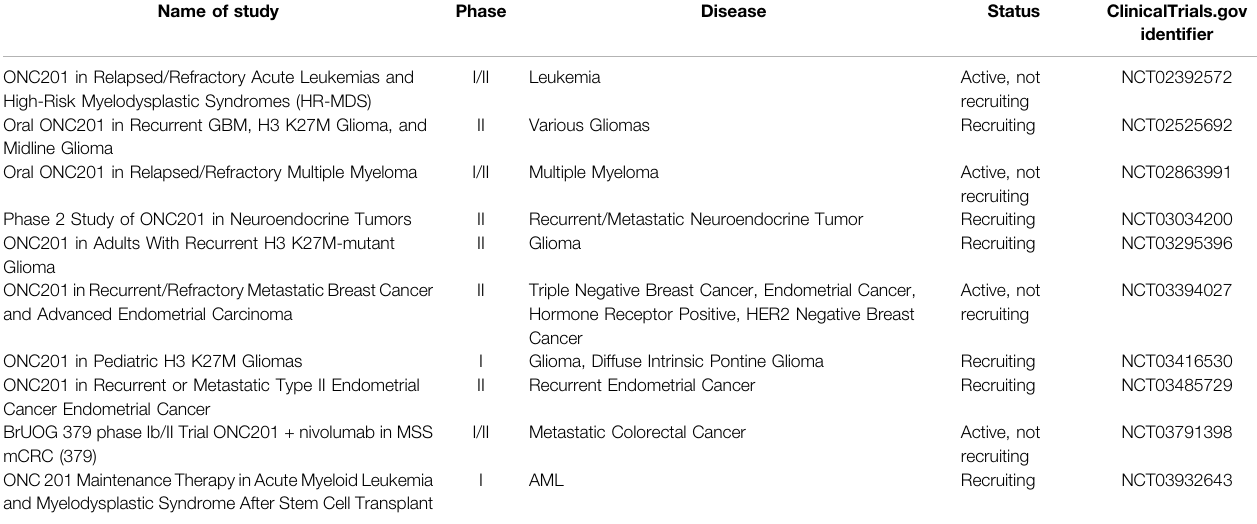
TABLE 1 | Current FDA Trials involving ONC201